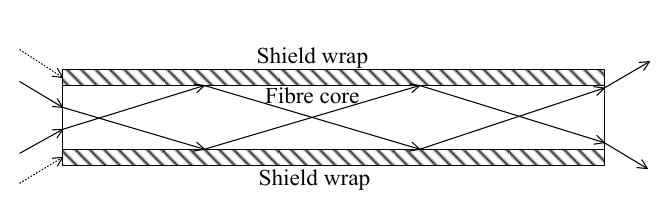
Figure 3. Diagram of FOFP structure.